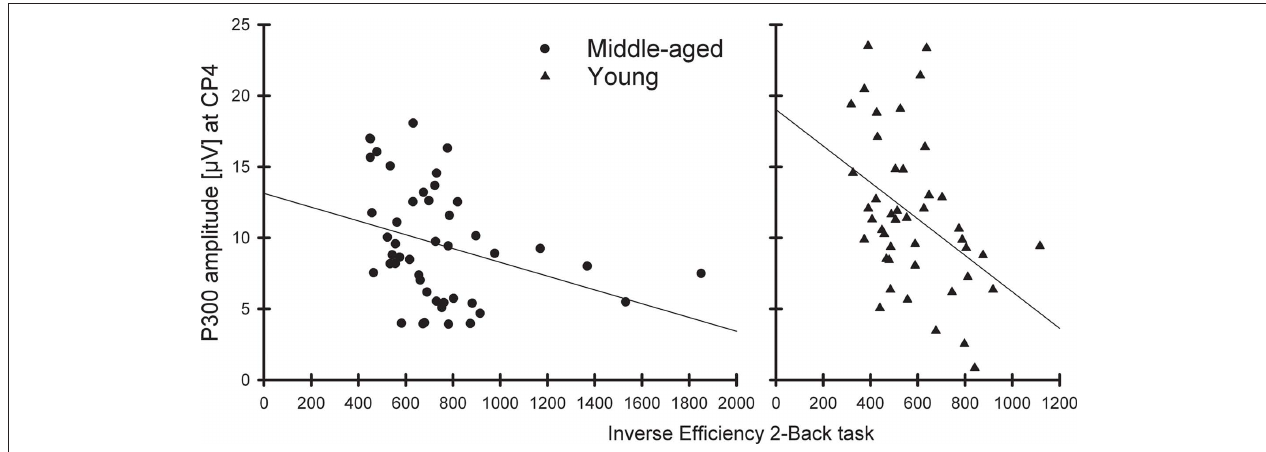
Figure 4 | correlation between the P300 amplitude (cP4 electrode) to non-targets before correctly detected targets with the inverse efficiency to targets in the 2-back task separately for the middle-aged (left) and young group (right).